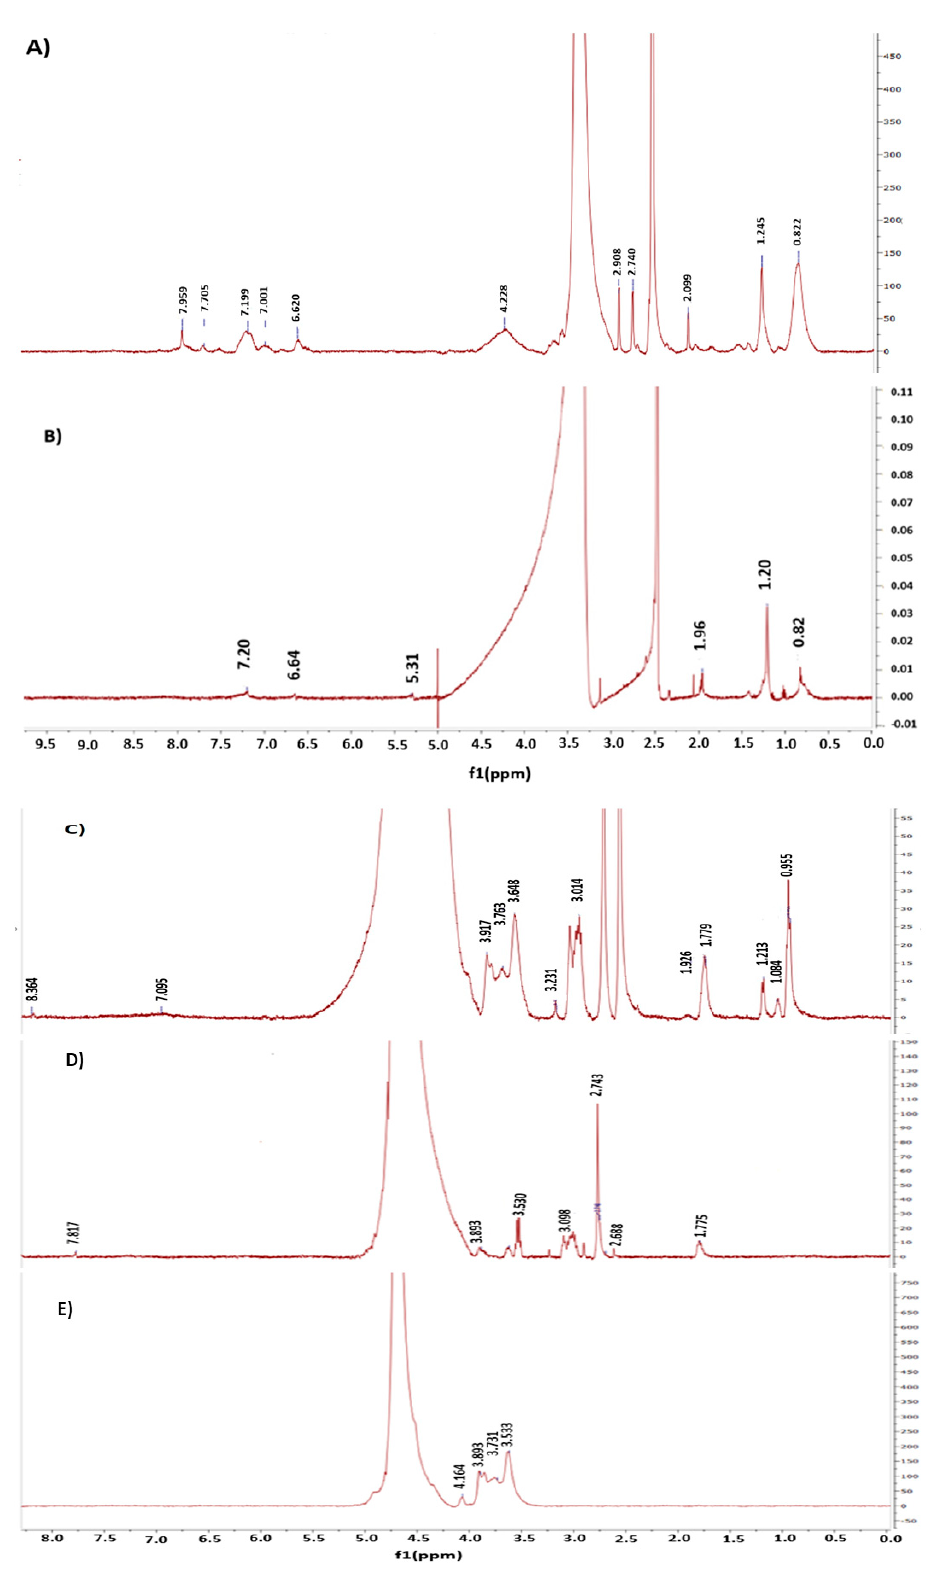
Figure 2. 1 H NMR (DMSO- d 6 ) spectra of ( A ): LF–RST, ( B ): LF and 1 H NMR (D 2 O) spectra of ( C ): PMT–ALG/LF–RST NHs, ( D ): PMT–ALG and ( E ): ALG.